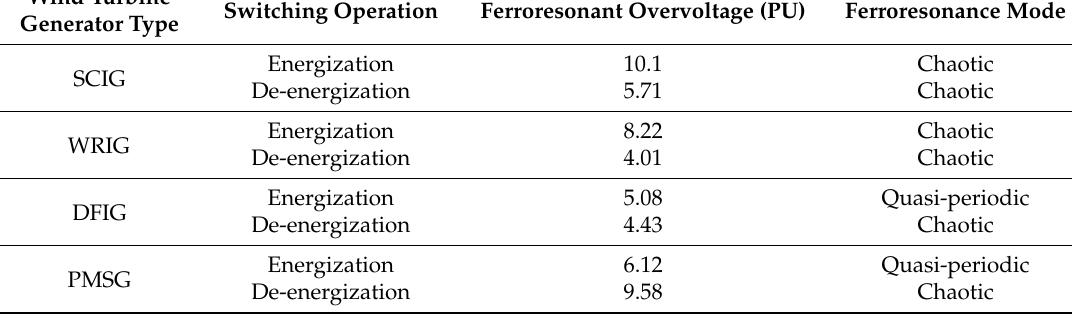
Table 7. Ferroresonant overvoltage during nuisance operations of the circuit breaker for different wind turbine